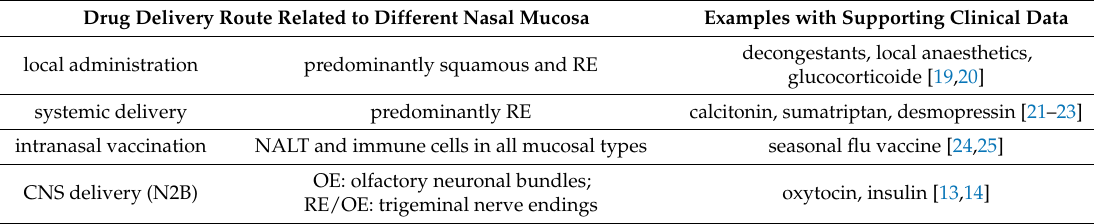
Table 1. Overview of drug delivery pathways related to the nasal cavity.